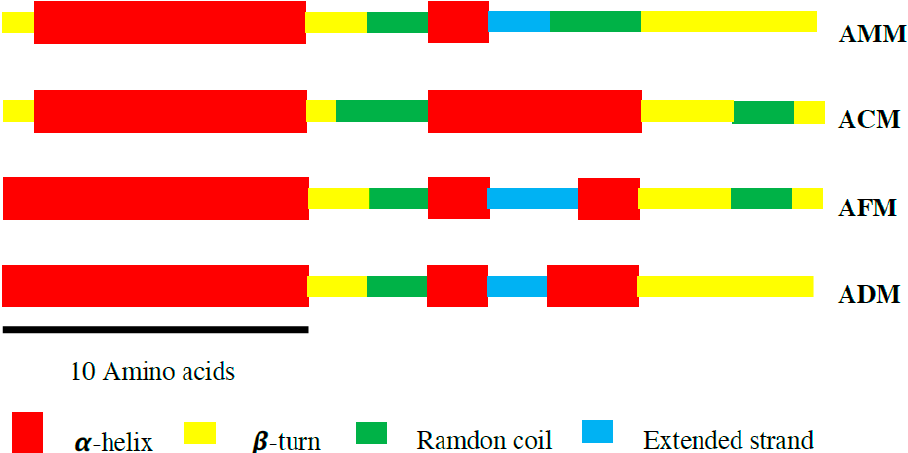
Figure 2. Schematic representation of the predicted molecular architecture of melittin from four honey bee species based on the secondary structural analysis via SOPMA. The computation of melittin from different honey bees showed a predominance of α -helices (red), followed by β -turns (yellow), random coils (green), and extended strands (blue). The scale bar represents the lengths of 10 amino acids.